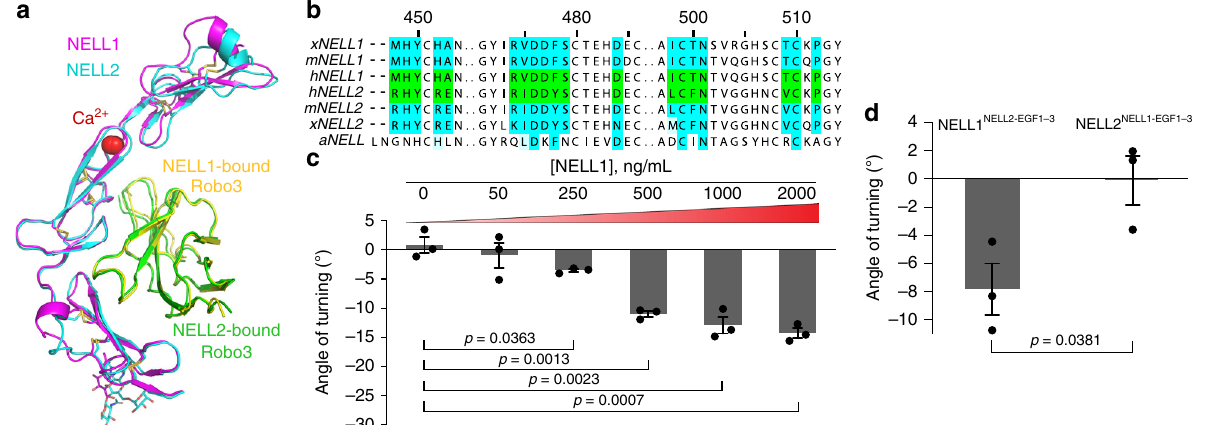
Fig. 5 Axon repulsive activities and interactions of NELL family members with Robo3 are conserved to varying degrees. a Crystal structure of hRobo3 FN1 bound to hNELL1 EGF1 – 3 (purple and yellow), overlaid with the hRobo3-hNELL2 structure (cyan and green). b Partial alignment of NELL sequences from Xenopus laevis ( x ), mouse ( m ), human ( h ), and the arthropod Aedes aegypti ( a ). Green squares indicate NELL residues at the Robo3-binding interface, which are highly conserved, except in aNELL. Blue positions are identical to human NELL1 or NELL2, while light blue represents conservative substitutions. Sequence numbering above the alignment is for hNELL2. c Quanti fi cation of commissural axon turning angles for increasing concentrations of NELL1 ( n = 3 for all conditions). d Quanti fi cation of commissural axon turning angles in response to 50 ng/ml NELL1/2 chimeric molecules ( n = 3 for all conditions). Error bars represent